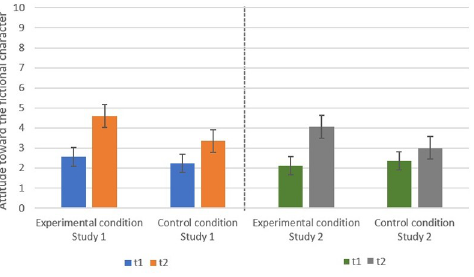
Fig 3. Significant interaction effects between time of measurement and condition regarding attitude toward the fictional character. Confidence intervals are represented by the error bars attached to each column.